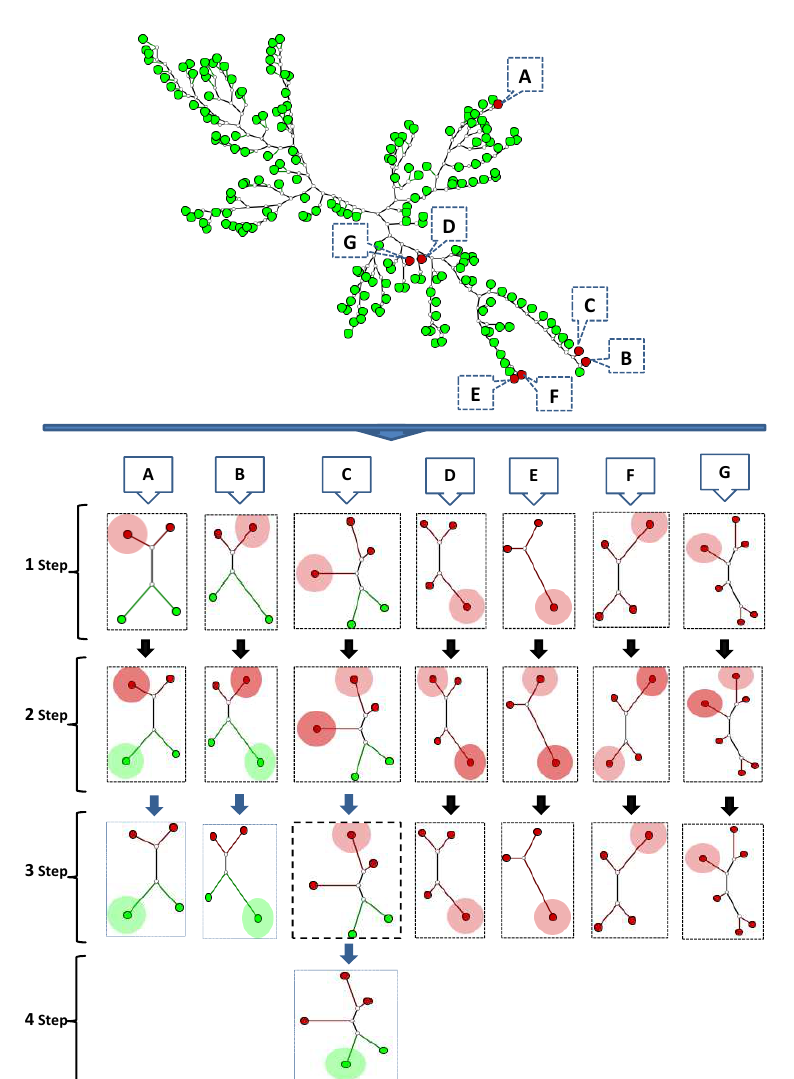
Figure 7. Instance Space Layout of each bag with an unsuitable instance prototype. A, B, C, D, E, F and G represent red bags.